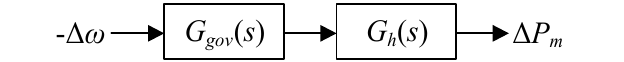
Figure 1. Open-loop system for a governor and a turbine. Symbols: ω , rotating speed; G gov , governor transfer function; G h , turbine transfer function; P m , mechanical power.